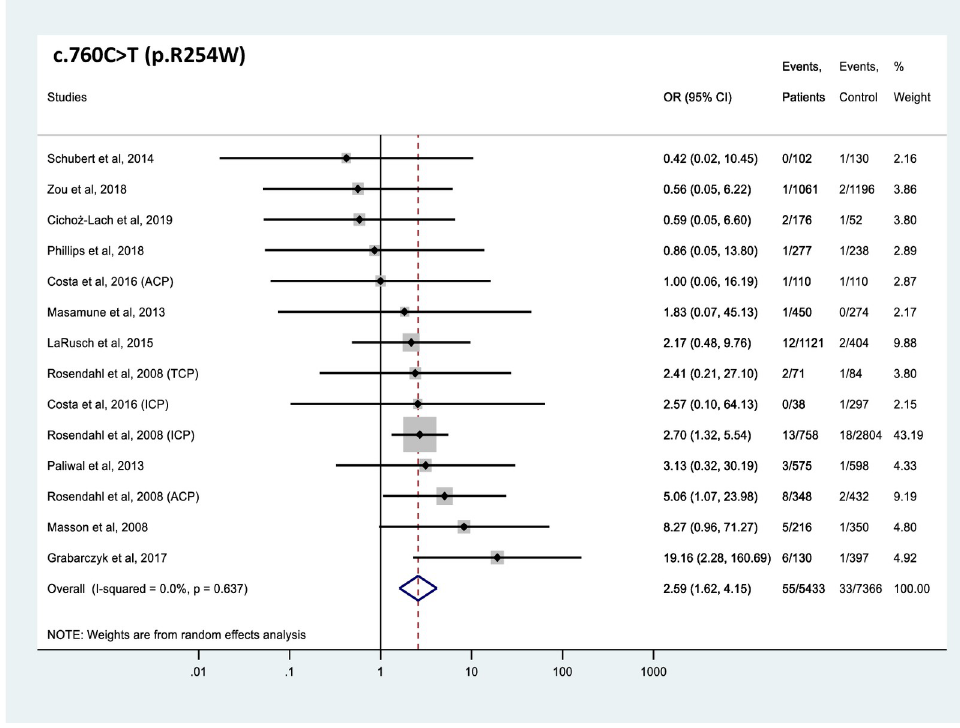
Fig 5. Forest plot showing odds ratios for pancreatitis risk in patients carrying the c.760C > T (p.R254W) CTRC variant. OR, odds ratio; CI, confidence